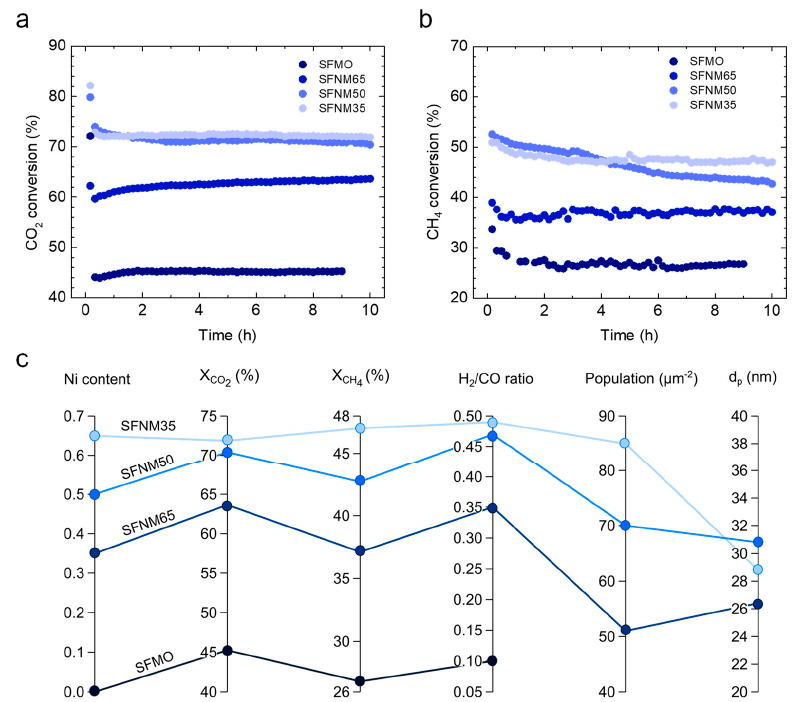
Figure 7. ( a ) CO 2 ( X CO2 ) and ( b ) CH 4 conversion ( X CH4 ) for the dry reforming reaction tests carried out at 850 °C, during 10 h in a fixed bed quartz tube reactor. CO 2 :CH 4 :Ar, 5:5:90, SV = 24 L g cat − 1 h − 1 ( c ) Composition–structure–performance comparative of Ni content, CO 2 , and CH 4 conversion, and H 2 /CO ratio at 10 h dry reforming test, nanoparticle population, and exsolved nanoparticle size ( d p ).